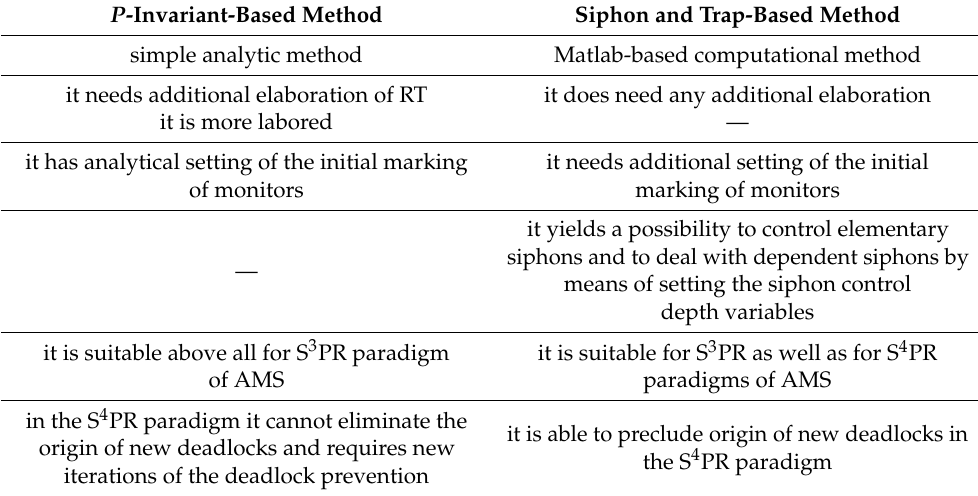
Table 1. Characteristics of both methods.